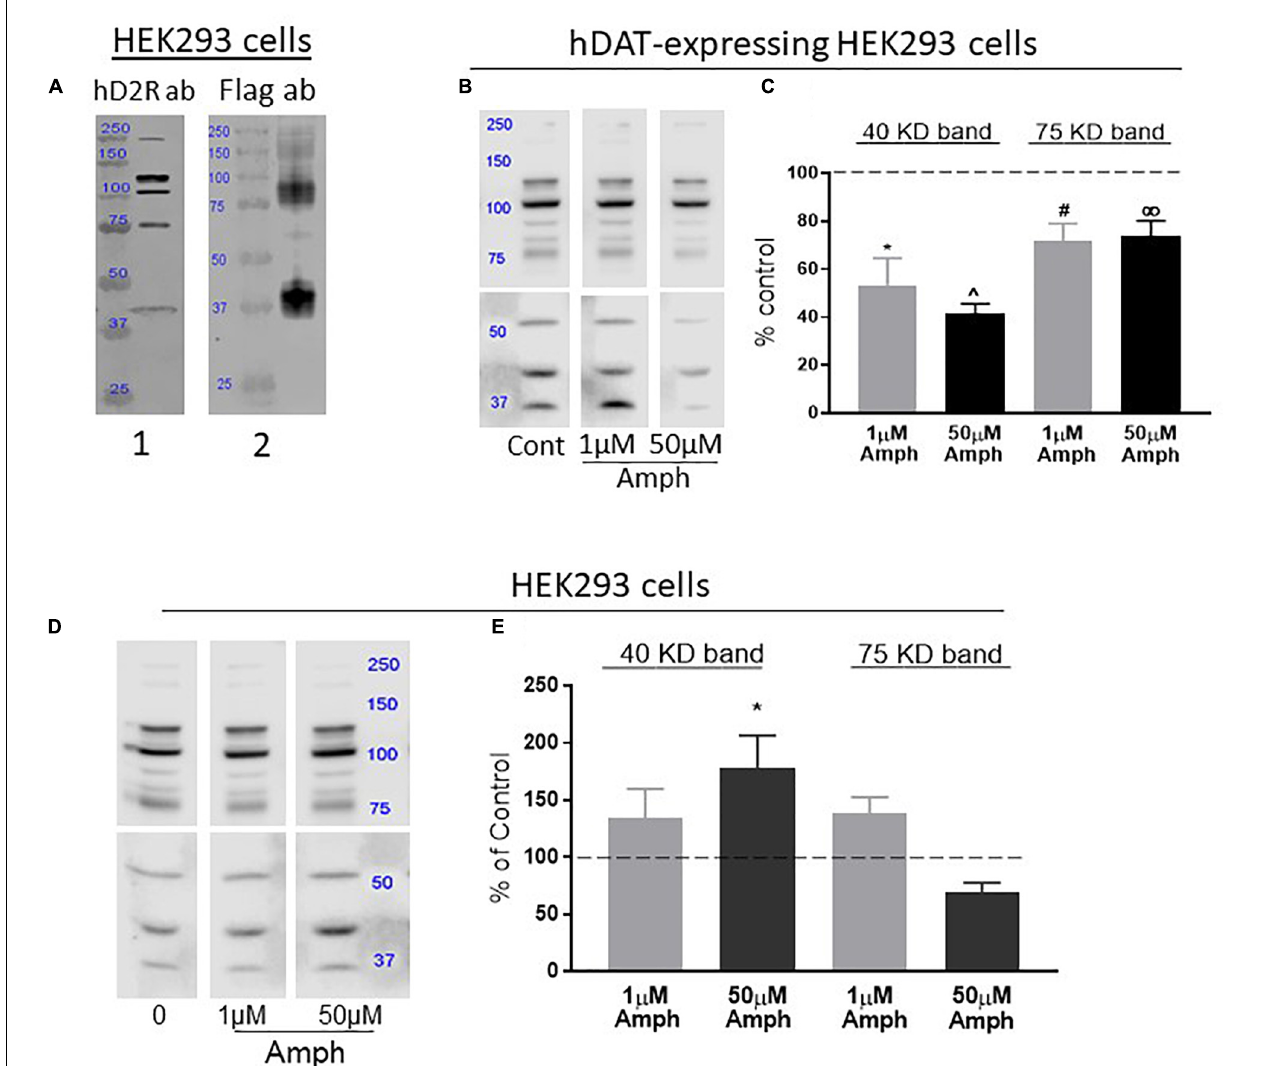
FIGURE 1 | Amphetamine (Amph) decreases the overall expression of the endogenous D2R in cells transfected with hDAT but increases D2R in cells lacking hDAT. (A) Antibodies against human D2R identify distinct bands in lysates from HEK293 cells (panel 1). Lysates from HEK293 cells transfected with Flag-D2R and probed with Flag antibodies show two prominent bands at 40 and 75 KD (panel 2). These bands match in size with bands probed with the hD2R antibody in panel 1. (B) A representative gel from hDAT-transfected HEK293 cells treated with control, 1 or 50 µ M amphetamine (Amph) and immunoblotted with hD2R antibodies is shown, and the average of 4 independent Western blot experiments is plotted in (C) . Statistical analysis against control-treated samples was performed using one-way ANOVA Dunnett’s multiple comparisons test (* p = 0.0007, ˆ p = 0.0001, # p = 0.01, ∞ p = 0.03, each compared to controls). (D) A representative gel of samples from HEK293 cells treated with control, 1 or 50 µ M Amph and immunoblotted with hD2R antibodies is shown, and the average of 4 independent Western blot experiments is plotted in (E) . PVDF membranes from Western blots in (B,D) are shown as two halves because different times of exposure to ECL were used. This guaranteed detectable and quantifiable signals at both lower and higher molecular weight bands (see section “Materials and Methods”). Statistical analysis was performed using one-way ANOVA Dunnett’s multiple comparisons test (* p =